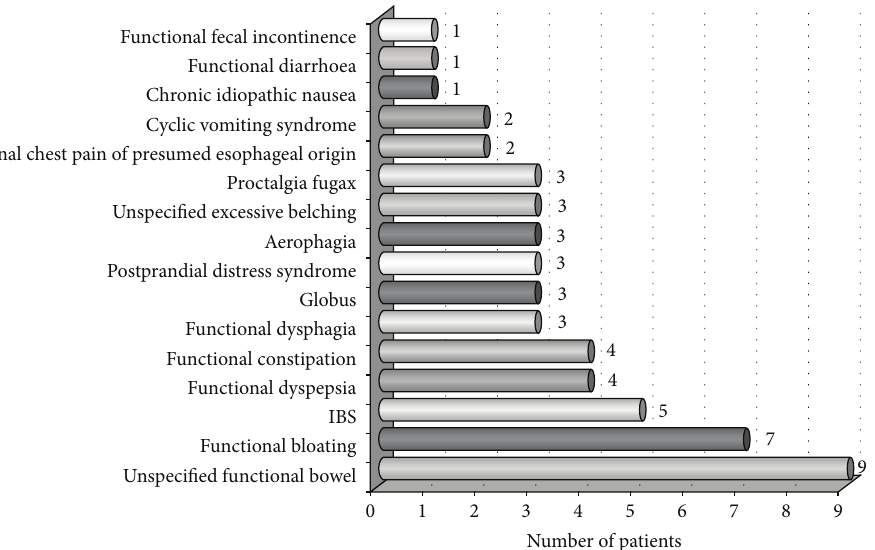
Figure 2: Prevalence of GI symptoms mimicking each subtype of FGID in the adult patients with